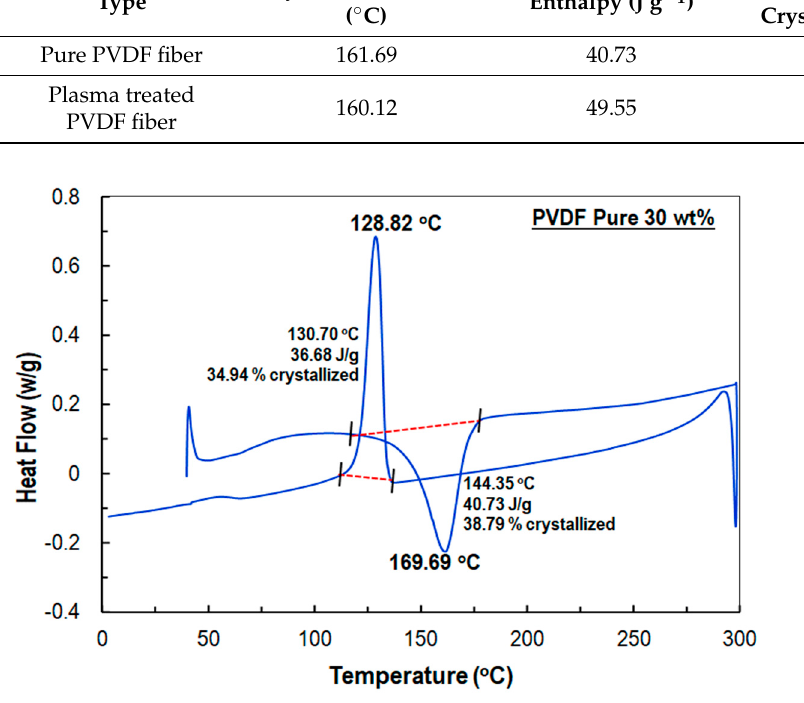
Figure 4. DSC thermograms of the baseline PVDF sample.